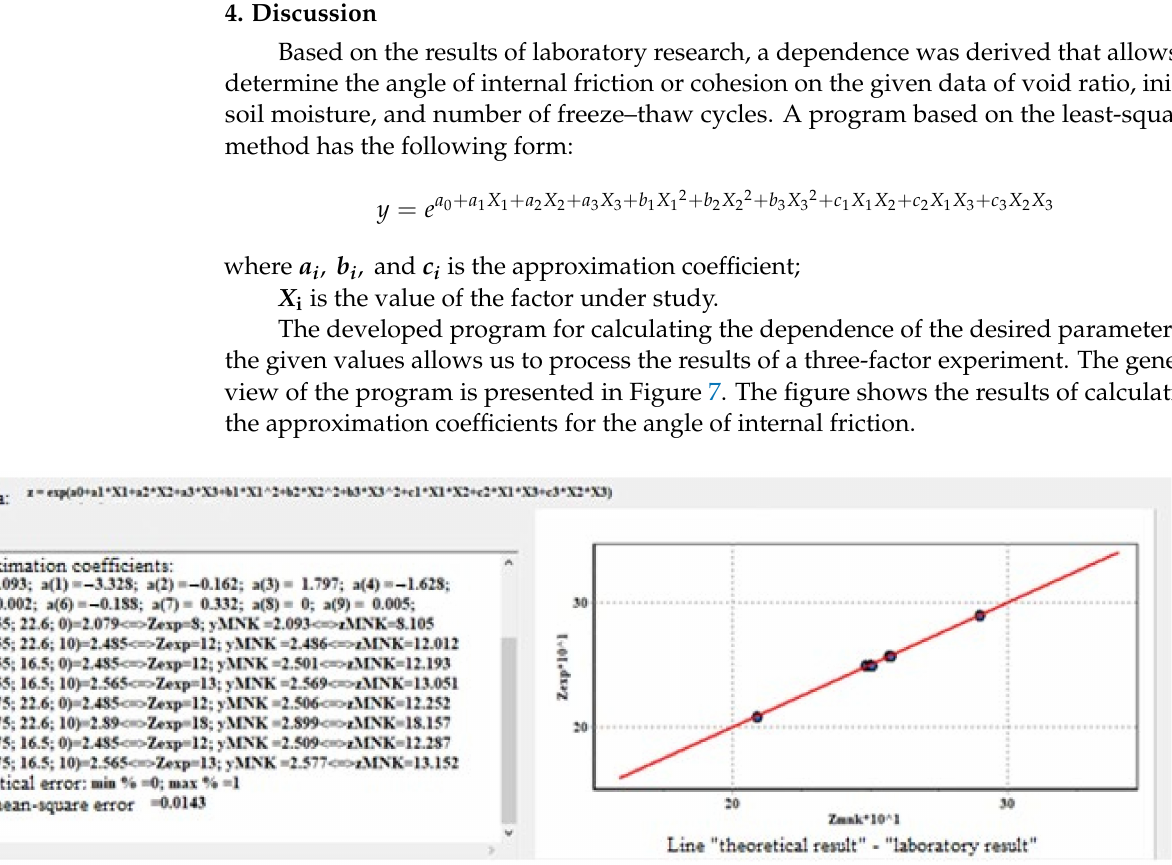
Figure 7. General view of the